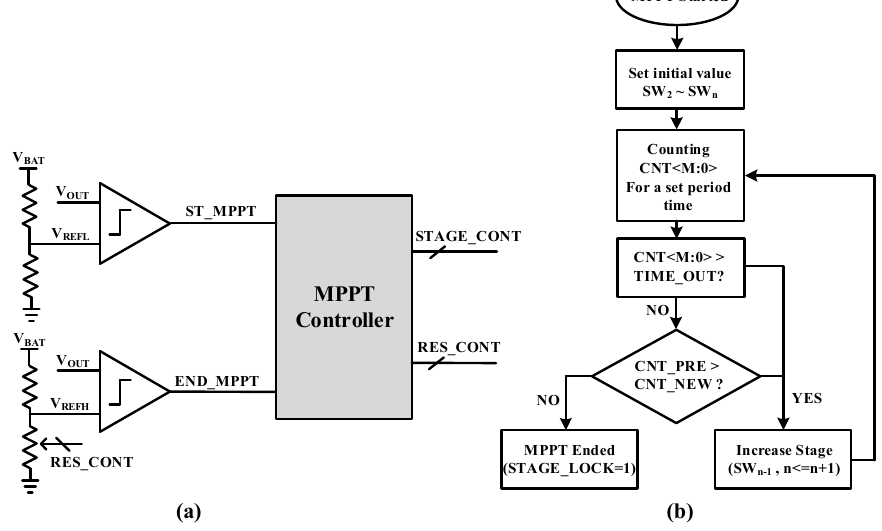
Figure 5. Maximum Power Point Tracking (MPPT). ( a ) Block diagram and ( b ) flowchart algorithm.